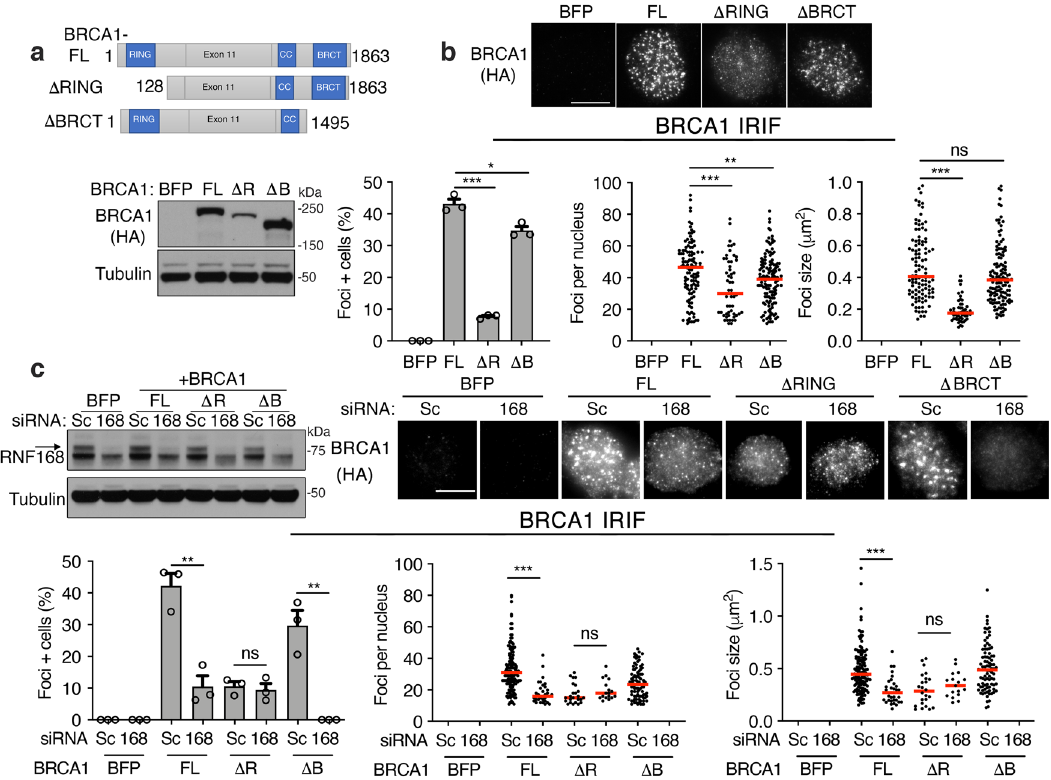
Fig. 2 RNF168 regulates BRCA1 RING-mediated foci. a Above; cartoon showing BRCA1 protein domains and truncations with aa numbers indicated. Below; BRCA1 null MDA-MB-436 cells expressing BFP control, HA-BRCA1-full-length (FL), HA-BRCA1- Δ RING ( Δ R), and HA-BRCA1- Δ BRCT ( Δ B) were assessed for HA protein levels by western blotting. b Cells from ( a ) were assessed for HA foci 8 h post IR by immuno fl uorescence. Above; representative images (scale bar, 10 μ m). Left; mean and S.E.M. percentage foci positive cells; middle, foci positive cells were assessed for the number of foci present in a single nucleus, red line: median value; right, foci positive cells were assessed for the mean size of foci present per nuclei, n = 3 biological replicates. Foci positive cells were determined to be those with ≥ 10 foci/nuclei. *** p < 0.001, ** p < 0.01, * p < 0.05, ns not signi fi cant compared to FL (percentage positive cells: unpaired, two-tailed t -tests size; number and size per nucleus: nonparametric Mann – Whitney tests). See Source data for additional information. c Cells from ( a ) were subject to scrambled (Sc) and RNF168-targeting siRNA followed by IR and HA foci formation measured by immuno fl uorescence. Left; western blot showing RNF168 depletion. Above; representative cells (scale bar, 10 μ m). Below; foci analyses as described in ( b ), n = 3 biological replicates. See Source data for additional